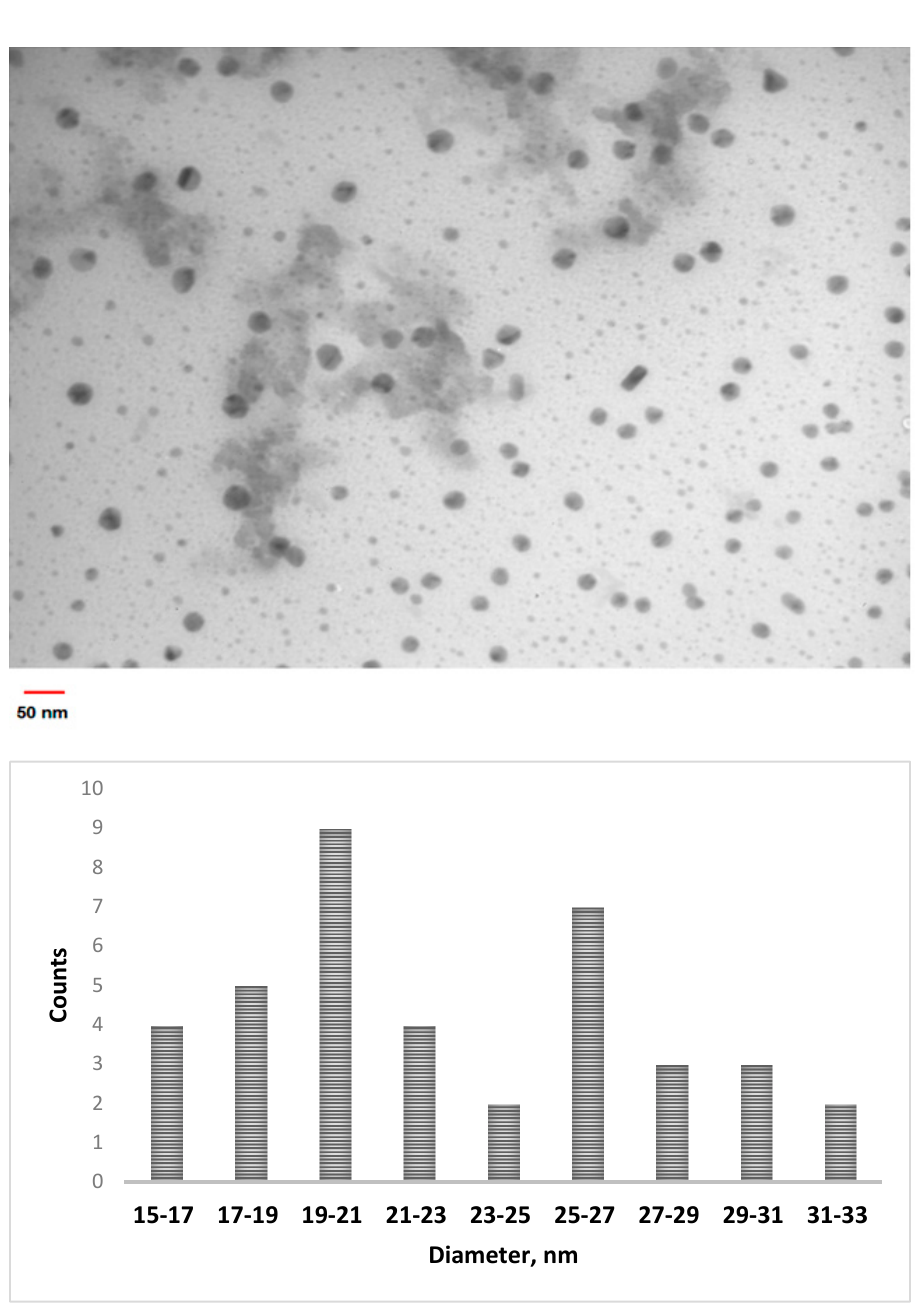
Figure 1. TEM image and bar graphs of diameter ranges of nano-SiO 2.